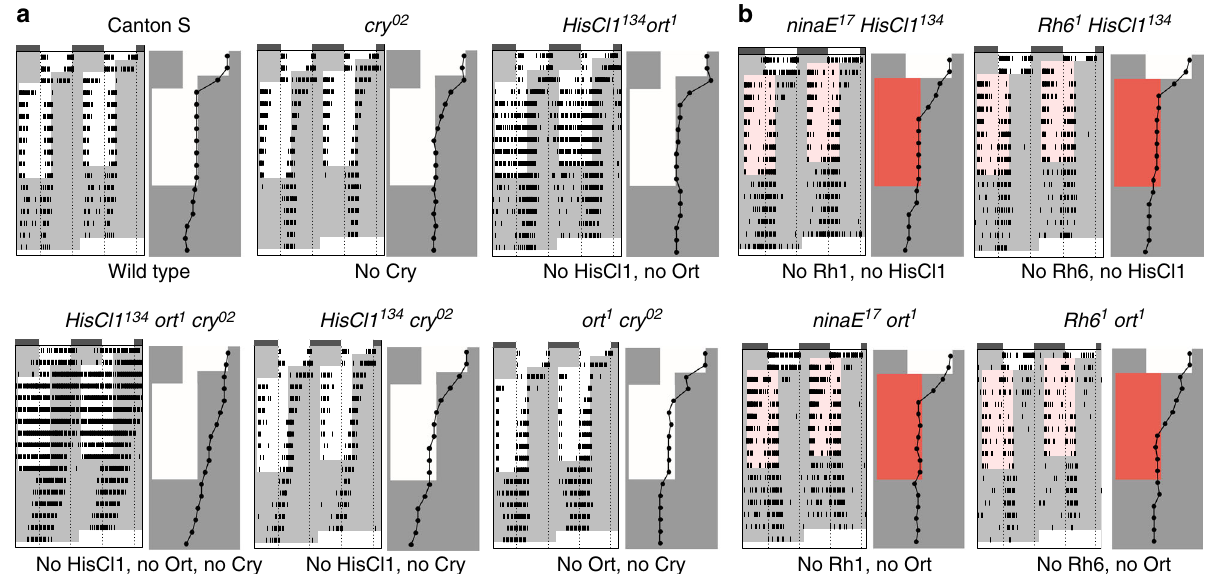
Fig. 1 HisCl1 and Ort histamine receptors can each transmit light input from Rh1- and Rh6-expressing PRs. a , b Average double plots of locomotor activity (actograms) of fl ies exposed to an 8 h advance of the LD/RD cycle, with corresponding phase plots (see Methods). Flies were initially entrained with both LD and temperature cycles (TC: 25 – 20 °C). a T°C was kept constant (25 °C) from the beginning of the day 3 light phase until the end of the experiment and the day 3 light phase was shortened by 8 h. Thus, fl ies were exposed to a novel advanced LD regime for 8 cycles followed by constant darkness (6 DD cycles). (Top) Wild-type fl ies (left) as well as fl ies with no Cry (center) or no histamine receptors (right) synchronize with phase advanced LD cycles. (Bottom) Flies with no Cry and no histamine receptors do not synchronize (left), whereas fl ies with no cry and only Ort (center) or only HisCl1 (right) do synchronize. b T°C was kept constant (25 °C) from the beginning of the day 2 light phase until the end of the experiment. Between days 2 and 3, the dark phase was shortened by 8 h and red light was used for the advanced light phase. Thus, fl ies were exposed to a novel advanced RD (red light) regime for 8 cycles followed by 6 DD cycles. Each of the four genotypes with only one histamine receptor and either Rh1 or Rh6 rhodopsin synchronizes with advanced RD cycles. Bars above actograms indicate the initial LD/TC cycles (black: lights-off, 20 °C; white: lights-on, 25°). White or red areas indicate the light phase of the cycle with white or red light respectively, and gray areas the dark phase of the cycle. Dots of the phase plots indicate the peak value of evening activity in LD/RD cycles and of activity in DD. n is the number of fl ies. Some genotypes (e.g., CHO , in ( a ) bottom left) have a free-running period that is slightly shorter than 24 h, which results in gradual advancement of the activity peak in DD or in LD/RD (also see other fi gures) when not